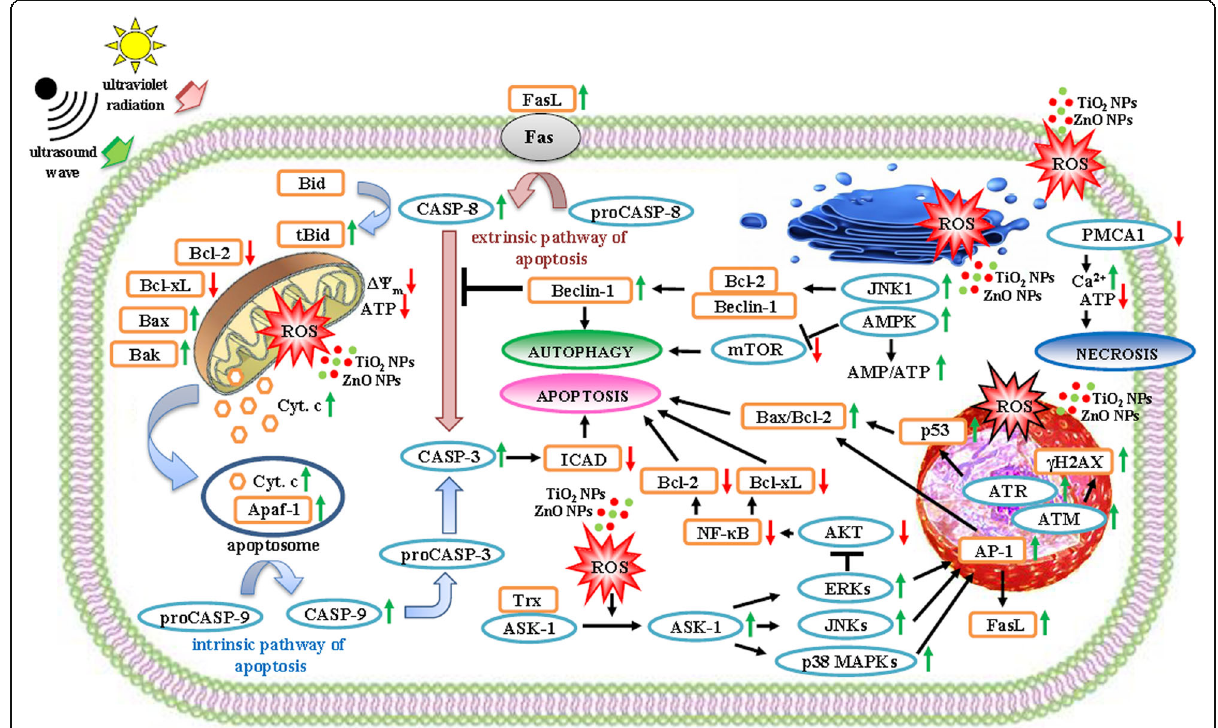
Fig. 3 Molecular mechanisms of reactive oxygen species (ROS)-mediated cell death pathways. Activated by ultraviolet (UV) radiation or ultrasound (US) wave, nanoparticles of titanium dioxide (TiO 2 NPs) and zinc oxide (ZnO NPs) induce ROS-mediated cell apoptosis, autophagy or necrosis. The increase of ROS level in cytoplasm results in thioredoxin (Trx) oxidation and apoptosis signal-regulating kinase 1 (ASK1) activation. ASK1 phosphorylates mitogen-activated protein kinases (ERKs, JNKs, p38 MAPKs) that control the AP-1-mediated synthesis of pro- (Bak, Bax) and anti-apoptotic (Bcl-2, Bcl-xL) proteins, as well as death ligands (FasL), thus promoting the cell apoptosis. Likewise, ERKs promote the cell apoptosis trough attenuation of activity of AKT kinase that controls the NF- κ B-mediated synthesis of Bcl-2 and Bcl-xL proteins. The oxidative damages of mitochondrion result in dissipation of mitochondrial membrane potential ( ΔΨ m ), decrease of ATP level and release of cytochrome c (Cyt. c) to the cytosol. Cyt. c, binding with apoptotic protease activating factor 1 (Apaf-1), induces the caspase-dependent apoptosis. The increase of ROS level in nucleus results in the activation of ataxia telangiectasia mutated (ATM), as well as ataxia telangiectasia and Rad 3-related (ATR) kinases that induce the p53-mediated apoptosis and account for the increase of DNA double-strand breaks marker ( γ H2AX) level. The ROS-induced endoplasmic reticulum stress results in the JNK1-mediated increase of pro-autophagic protein (Beclin-1) level and the AMPK-mediated inhibition of autophagic inhibitor, mammalian target of rapamycin (mTOR) kinase. Both processes lead to the cell autophagy. The oxidative injuries of plasma membrane result in the downregulation of plasma membrane calcium ATPase 1 (PMCA1), in the decrease of ATP level and the increase of Ca 2+ level. As a consequence, the cell necrosis